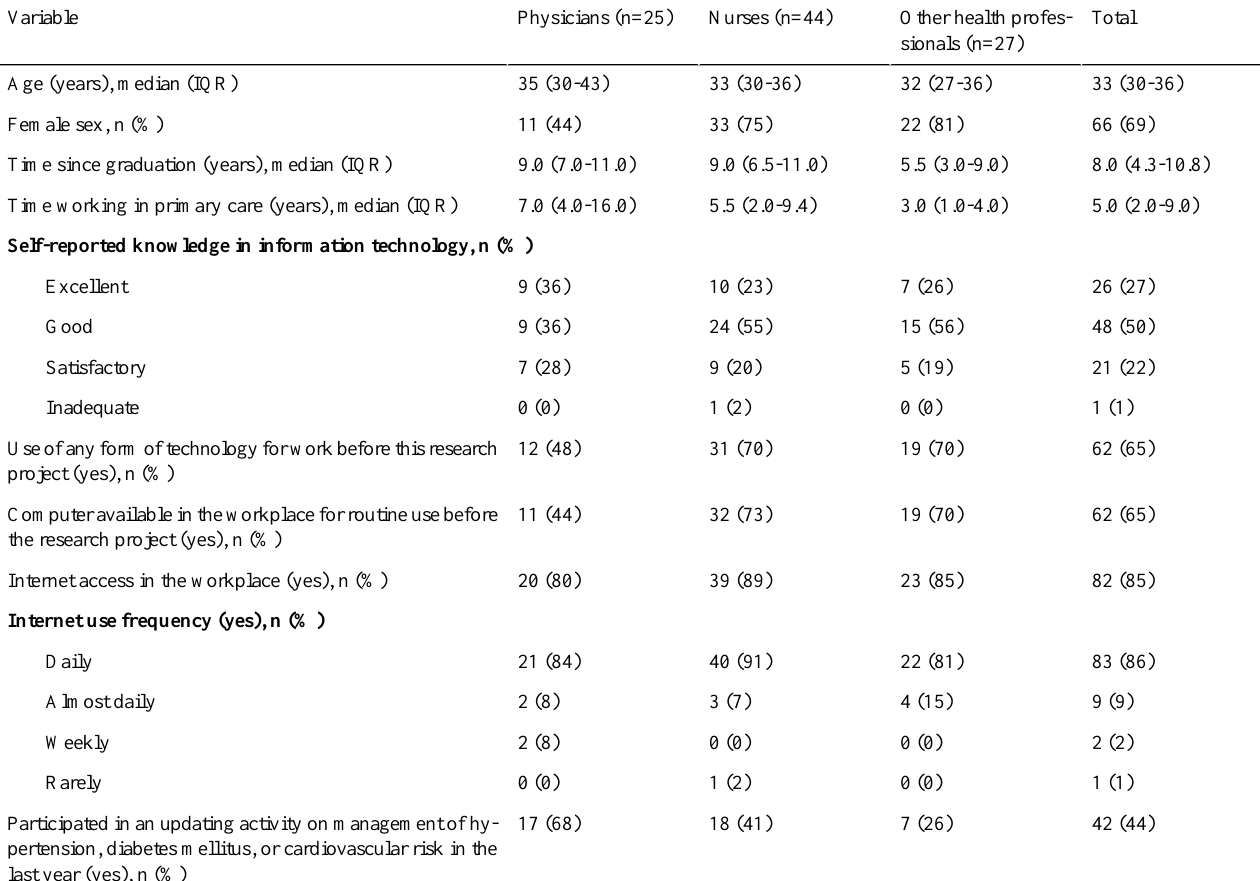
Table 1. Characteristics of health care professionals who participated in the study (N=96).